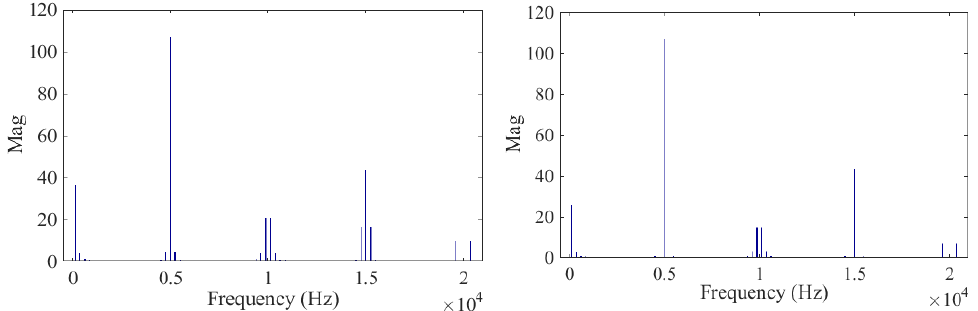
Figure 9. FFT analysis of CMV for DZIPWM: ( left ) the sub-CMV V cm 1 ; ( right ) total CMV V cm .